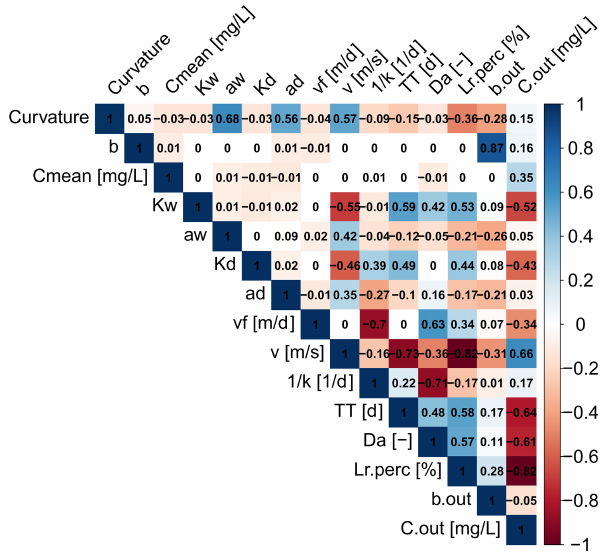
Figure 5. Correlation matrix for the model parameter inputs: chan- nel depth and width exponents ( a d , a w ) and coefficients ( K d , K w ); slope of the land-to-stream loading ( b ); concentration of the land-to-stream load ( C mean ); uptake velocity ( v f ); and the outputs bending of the log (C) –log (Q) relationship at the catchment outlet (Curv max ), effective stream velocity ( v ), first-order uptake constant ( k ), travel time (TT), Damköhler number (Da), daily percentage of load removed ( L r.perc ), and slope of the log (C) –log (Q) relation- ship and median concentration at the outlet ( b out and C out ). The Spearman rank correlation coefficients ( ρ ) are given for each com-